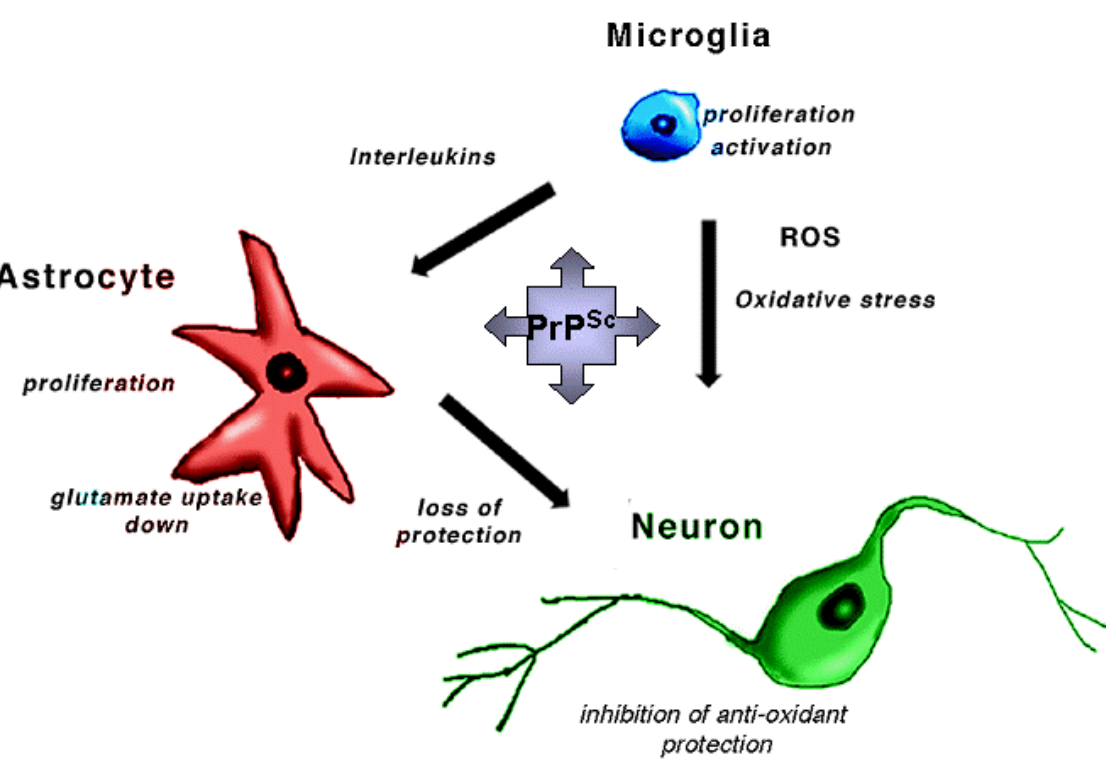
FIGURE 1. Schematic representation of the interaction of neurons and microglia in a model of prion disease. The abnormal isoform of the prion protein (PrP Sc ) is generated during the course of prion disease. It is considered both the infectious agent and the cause of neuronal loss. Its neurotoxicity results from a mixture of direct and indirect effects. PrP Sc causes a reduction in neuronal resistance to oxidative stress, but also causes activation of microglia and stimulates their proliferation. The production of reactive oxygen species (ROS) and cytokines from the microglia has significant knock-on effects, causing stimulation of astrogliosis and toxicity to neurons. PrP Sc also inhibits astrocyte clearance of glutamate, further increasing neuronal